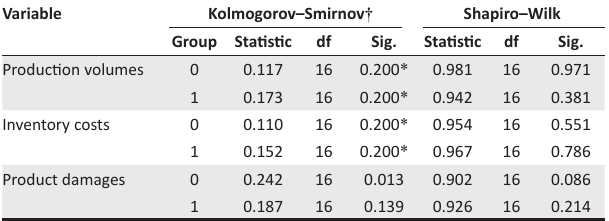
Table 2 indicates that the percentage mean data for pre- inventory sequencing for product volumes, inventory costs and product damages were 40.31%, 43.75% and 48.44%, respectively. However, the percentage mean data of post- inventory sequencing for production volumes, inventory costs and product damages were 33.0%, 22.50% and 22.56%, respectively. The results show a decrease in mean values on all three variables (i.e. the production volumes, inventory costs and product damages) when post-inventory sequencing is compared with the pre-inventory sequencing periods. This indicates the effect of inventory sequencing system on inventory control. TABLE 1: Normality tests for production volumes, inventory costs and product damages. Variable Kolmogorov–Smirnov † Shapiro–Wilk Group Statistic df Sig. Statistic df